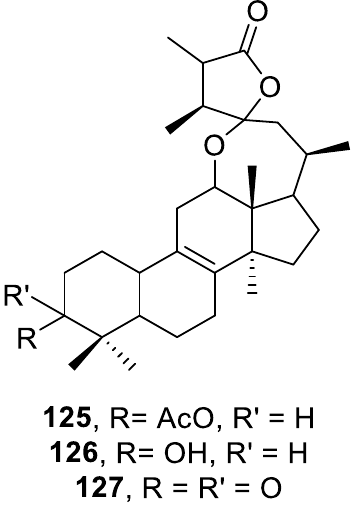
Figure 60. Fomlactones A–C possessing a [4.6.0] spirocyclic moiety.